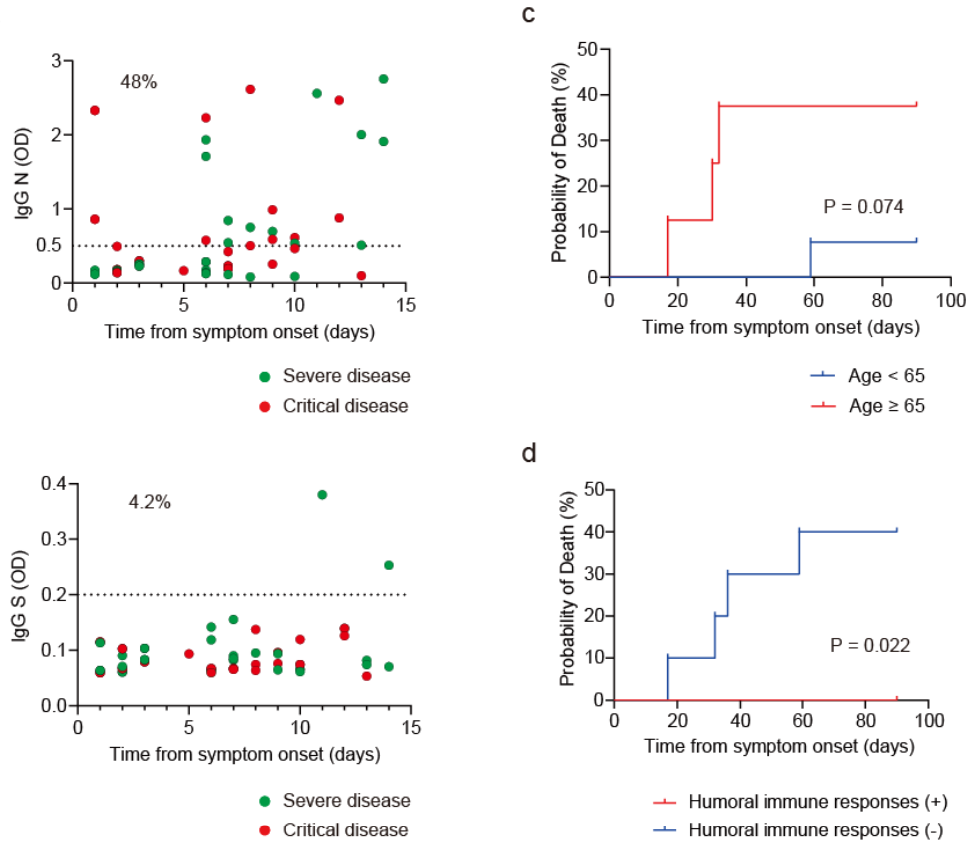
Figure 6. Humoral Immunity to SARS-CoV-2 in hospitalized COVID-19 patients. ( a ) IgG N titers of COVID-19 patients diagnosed with severe (green circles) or critical (red circles) disease. ( b ) IgG S titers of COVID-19 patients diagnosed with severe (green circles) or critical (red circles) disease. ( c ) Kaplan – Meier survival curves of critical COVID-19 patients according to age (blue bar; age <65, red bar; age ≥65 ). ( d ) Kaplan – Meier survival curves of critical COVID-19 patients with (red bar) or without (blue bar) humoral immune responses to SARS-CoV-2 N.